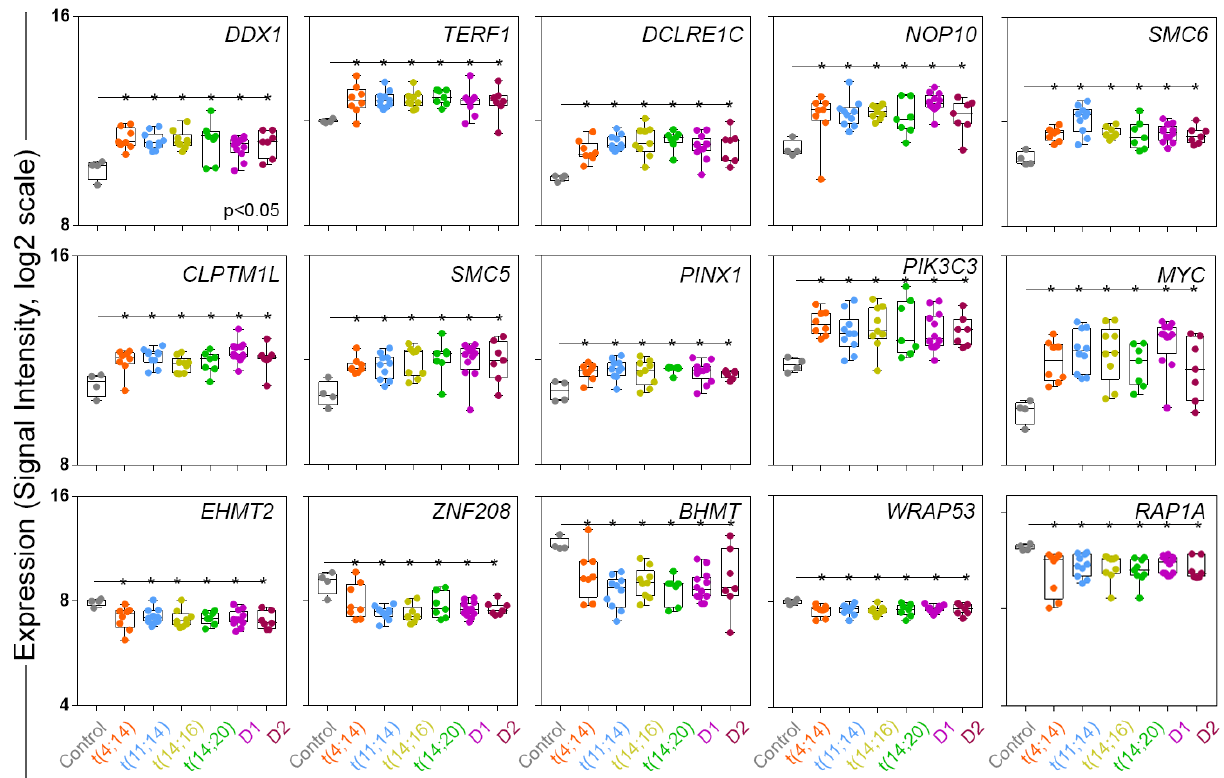
Figure 2. Selective TRGs are significantly ( p < 0.05) differentially upregulated ( n = 10) or downregulated ( n = 5) across major IgH translocation ( n = 4) and hyperdiploidy ( n = 2) subgroups in a cohort of patients with NDMM, compared to control. Abbreviations: IgH , immunoglobulin heavy chain locus; NDMM, newly diagnosed multiple myeloma; TRG, telomere-related gene.